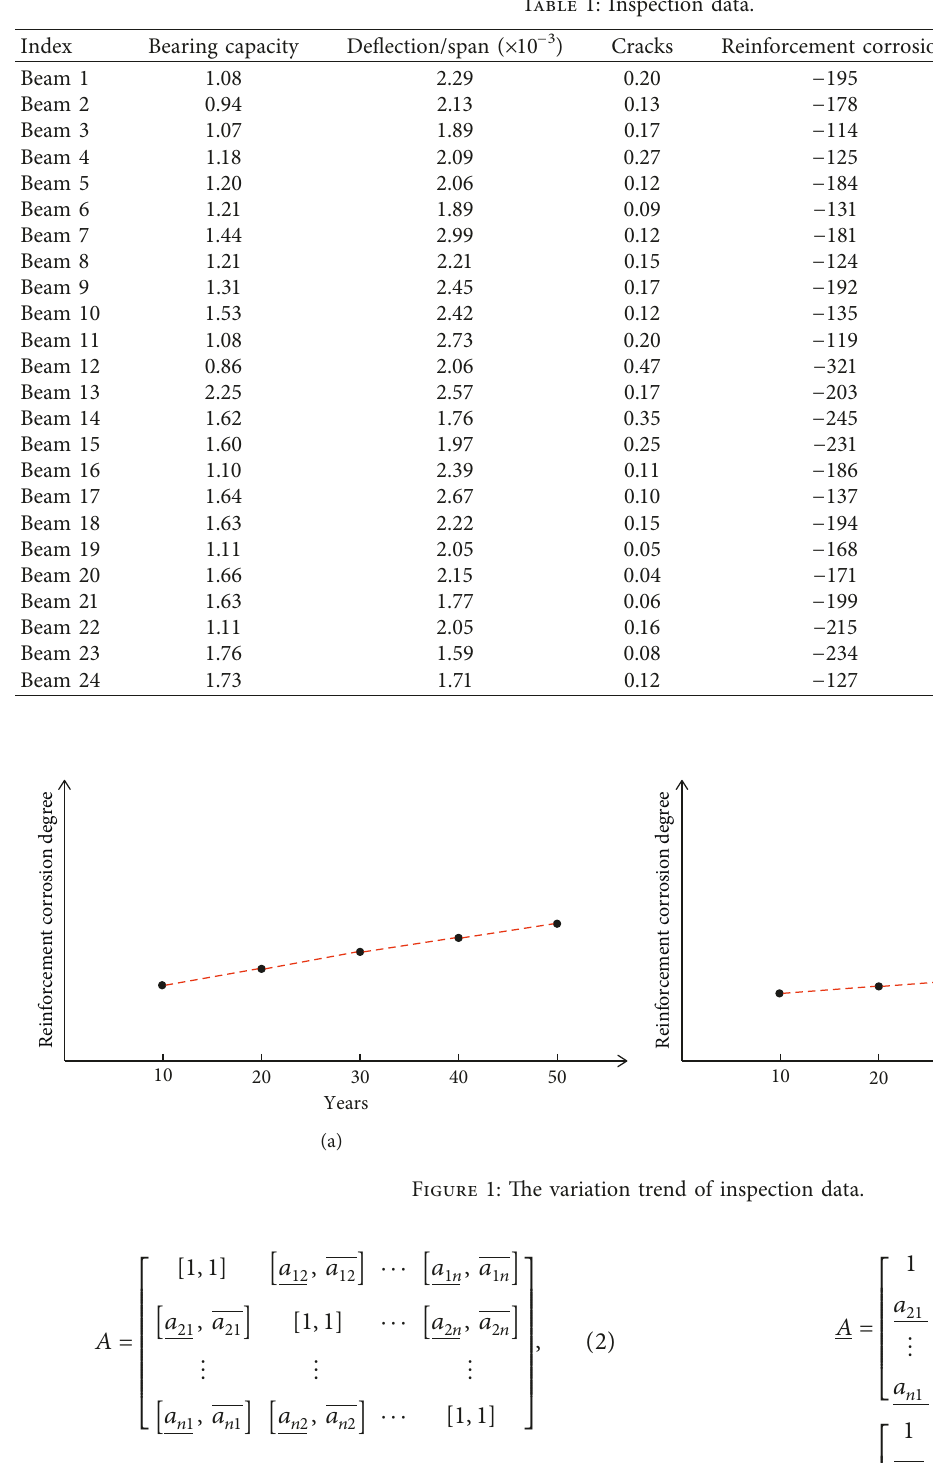
Table 1: Inspection data.